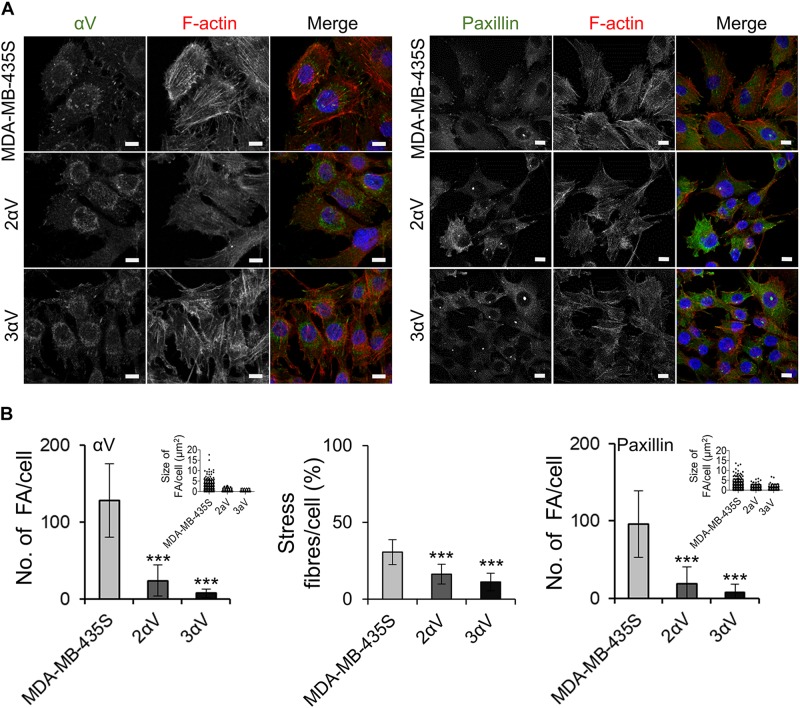
Clones 2αV and 3αV have decreased number and size of FAs and decreased amount of stress fibers per cell as compared to MDA-MB-435S cells. (A) Clones 2αV and 3αV show decreased expression of the integrin subunit αV and the FA marker, paxillin. Forty-eight hours after seeding on coverslips, cells were fixed, permeabilized and stained with antibody against integrin αV or paxillin followed by Alexa-Fluor 488-conjugated antibody (green). F-actin staining (red) was performed in all samples, and nuclei were stained with DAPI (blue). Analysis was performed using TCS SP8 Leica. Scale bar = 10 μm. (B) Quantification of αV and paxillin, FA size and % of stress fibers per cell. Data presented as histograms or scatter plots (FA size) represent measurements of > 50 cells and are plotted as mean ± SD (n = 3). Data were analyzed by one-way ANOVA with Dunnett’s multiple comparison. ***P < 0.001.